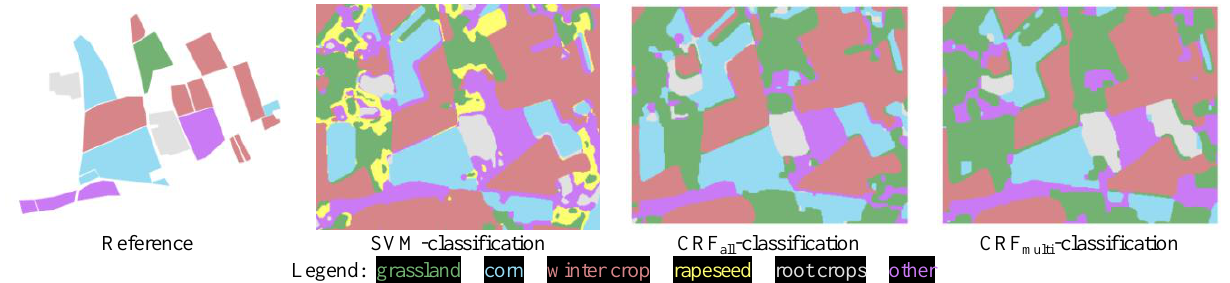
Figure 3. Reference data and classification results in comparison